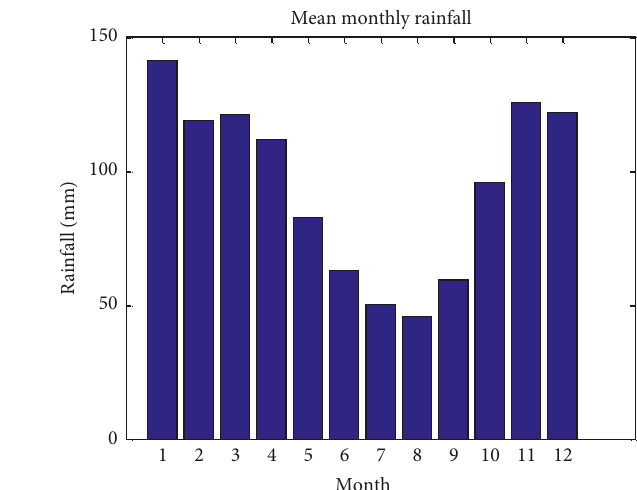
Figure 5: Histogram of the mean monthly rainfall in Haikou, China.